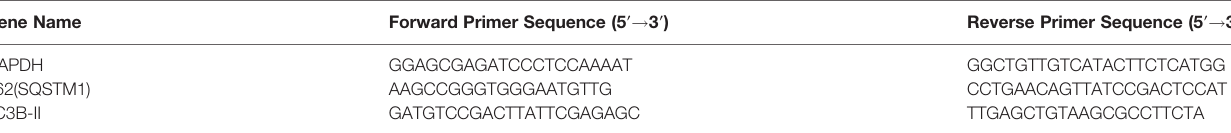
TABLE 1 | Sequences of primers for quantitative real-time